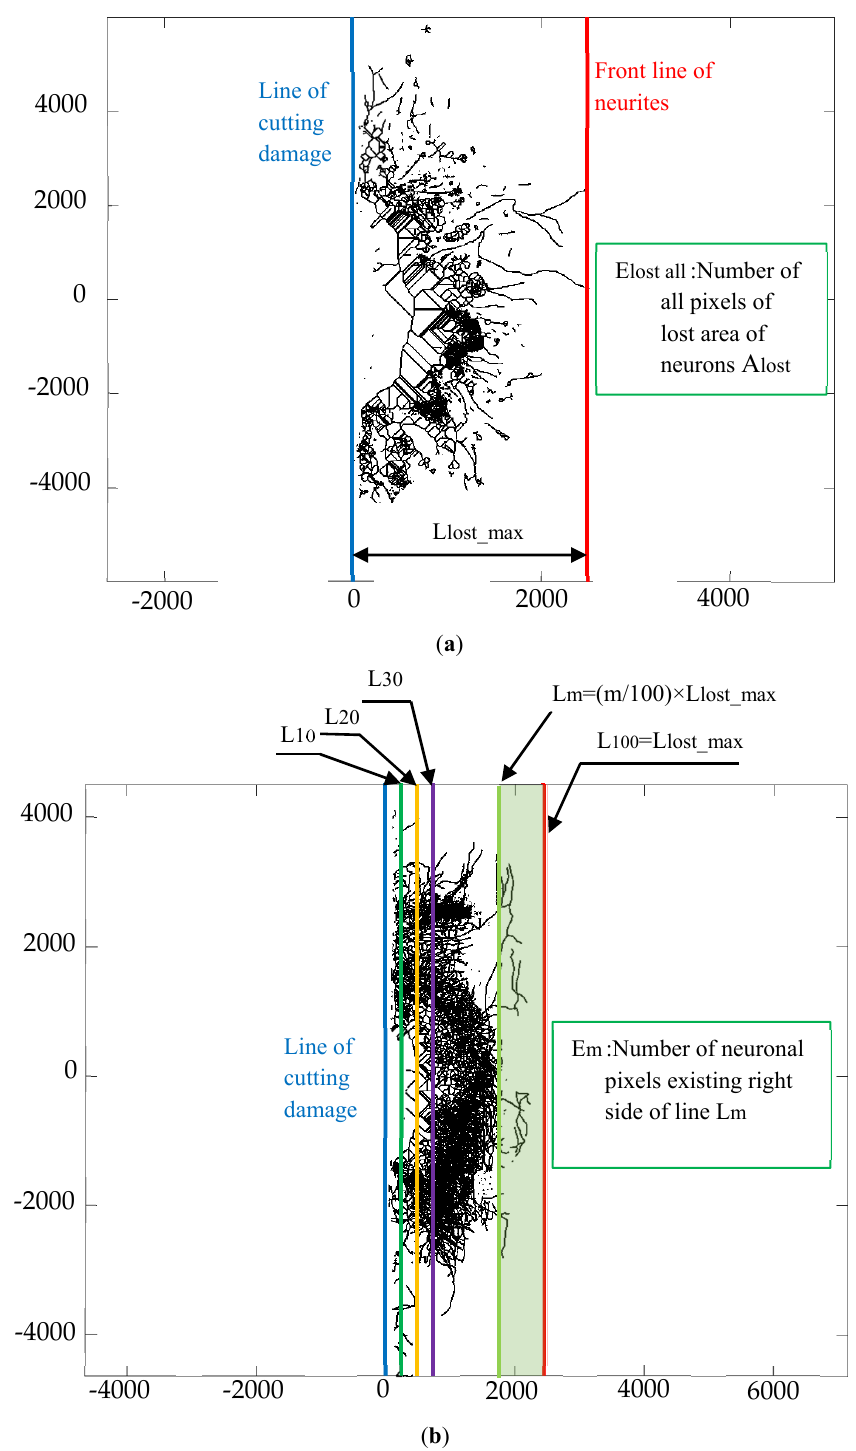
Figure 9. Definitionsofparametersfortheevaluationofextensibilityofthereconstructedneuritesofthecolony[=(E m /Elost all) × 100] based on the typical binarized immunostained images. The value of m indicates the location line up to which the neuronal pixels are counted for, with m = 100 coinciding with Llost_max., while E m is the number of neuronal pixels existing on the right side of line L m defined on reconstructed neurites of the colony after the cutting damage. ( a ) Definition of Llost_max:maximum straight-line length of neuron colony measured from edge line of the cutting damage to the furthest front line of the lost neurons; ( b ) L m and E m defined on reconstructed neuron